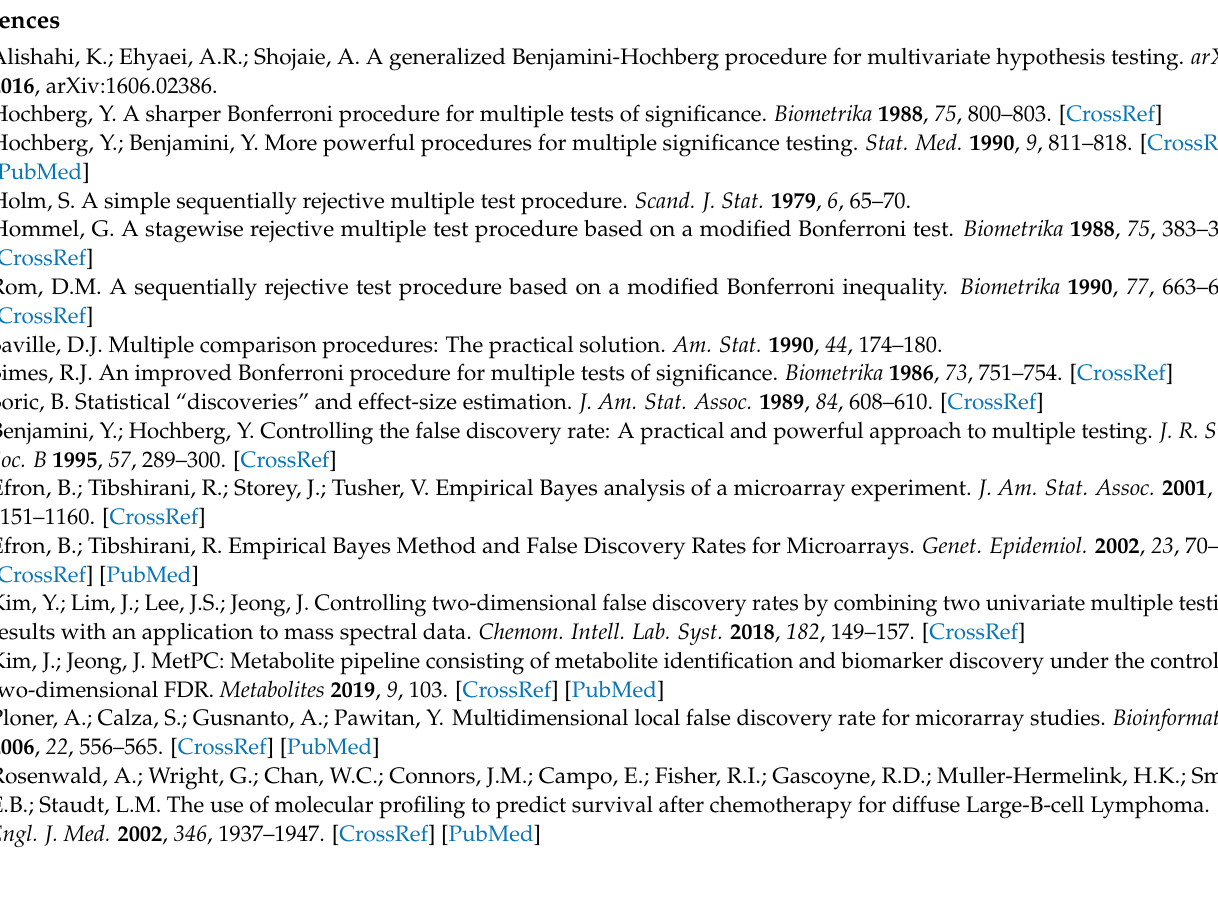
Table S2: Basic scenario (one-sided alternative): Performance measure when cutoff =